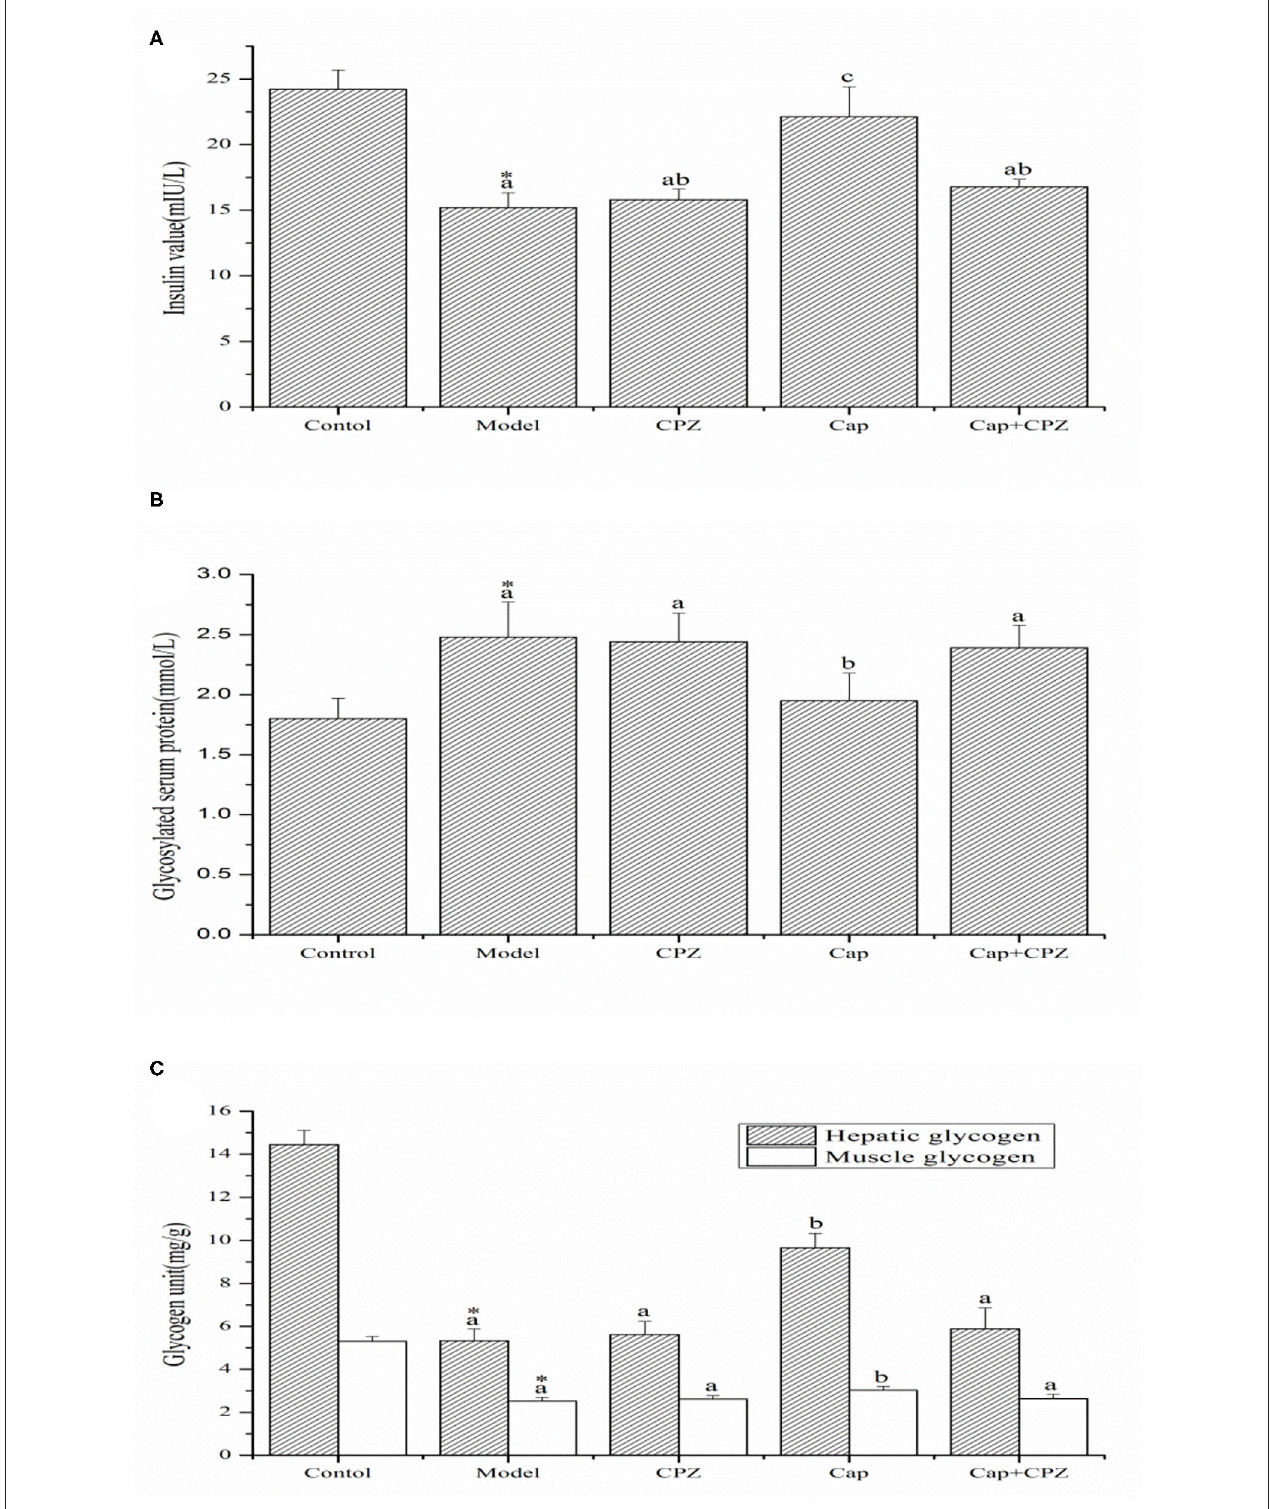
FIGURE 2 | Effects of TRPV1 receptor antagonist and capsaicin on the serum insulin (A) , glycosylated serum protein (B) , and hepatic glycogen and muscle glycogen (C) in STZ-induced diabetic rats. All data are expressed as means ± SD, n = 8. *Means are significant difference compared with the model group ( P < 0.05). Means with different superscript letters are significantly different among the diabetes groups ( P < 0.05). Effective concentrations of capsaicin and capsazepine are 6 and 10 mg/kg · BW, respectively.